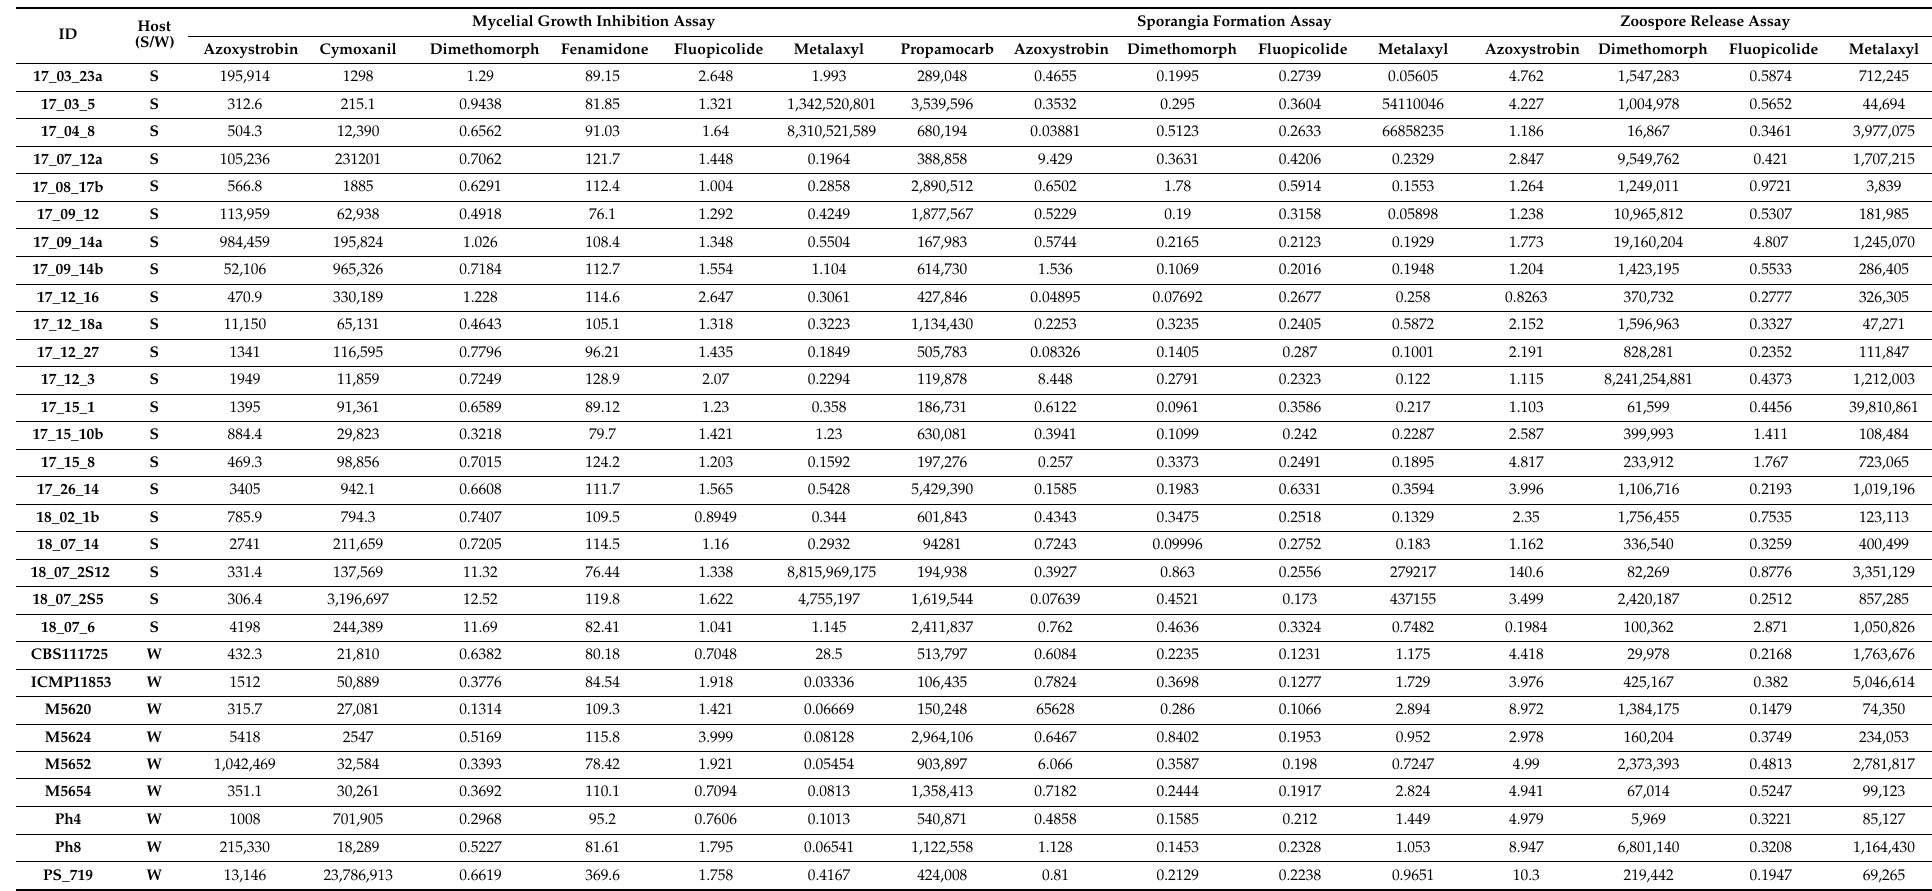
Table 3. EC 50 values recorded for all P. cactorum isolates against tested fungicides in the mycelial growth inhibition, sporangia formation and zoospore release